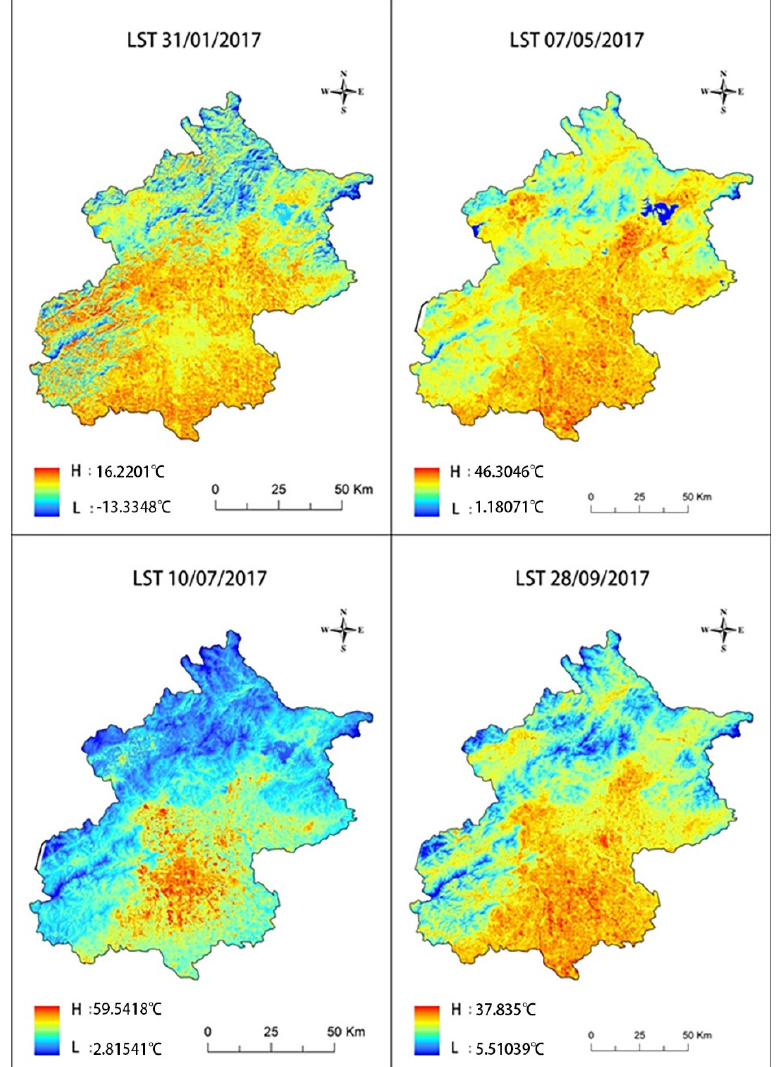
Figure 1. The LSTs of Beijing: 31 January 2017, 7 May 2017, 10 July 2017, and 28 September 2017.